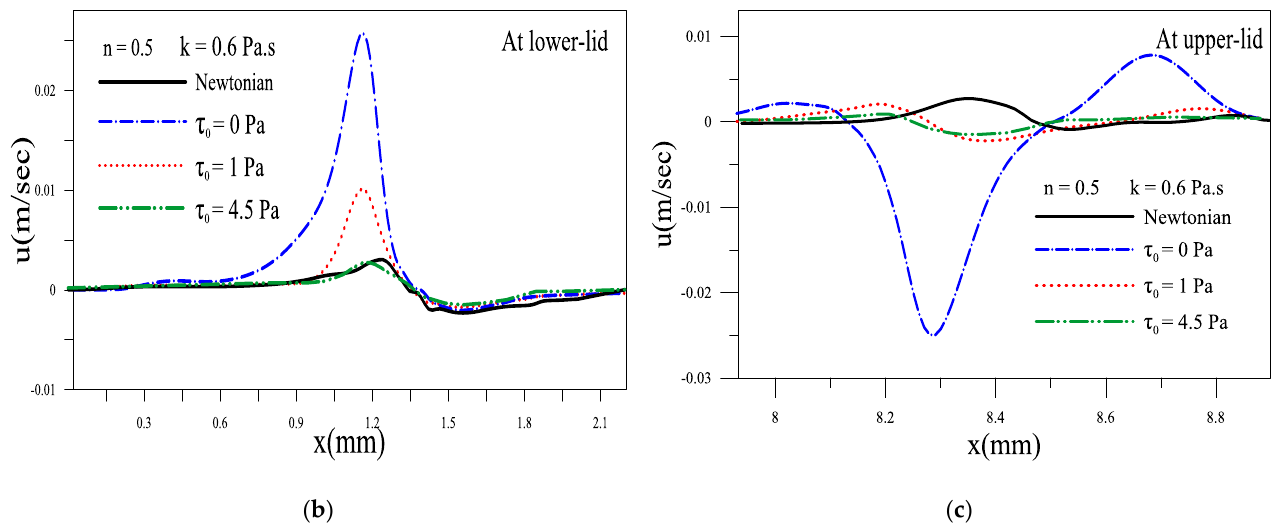
Figure 7. Depth average velocity for different. yield stress τ 0 at time = 0.18 s. ( a ) over the whole cornea surface, ( b ) and ( c ) a closeup near the lower and upper eyelid.